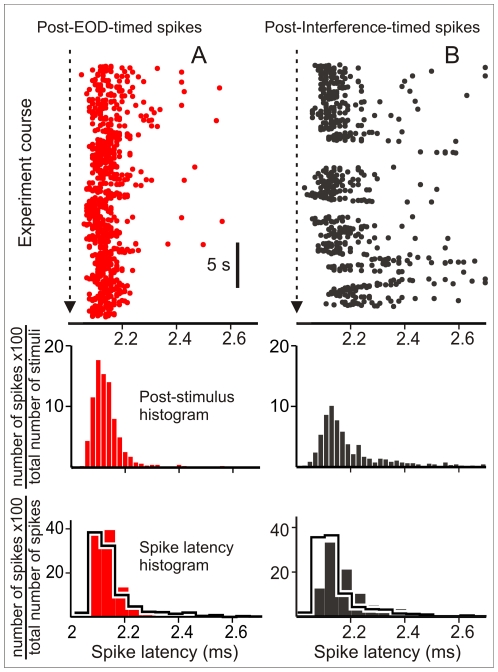
Interference and EOD timed stimuli are not equally effective.A) Top: Post stimulus raster plot of the spiking responses to EOD-timed pulses applied as in the natural sequence (red dots). Middle: corresponding post stimulus histogram (ordinate: 100× EOD evoked spikes per bin divided total number of EOD-timed stimuli, red bars). Bottom: The responsiveness to the natural patterns was compared with the responsiveness to the same set of intervals applied in a shuffled sequence in a pair wise experiment (histograms in heavy black lines). For the sake of clarity spike latency histograms showing the relative frequency of the latency after the cell spiked (ordinate: 100× EOD evoked spikes per bin divided total number of EOD evoked spikes) were constructed with a different bin size. B) Top: Post stimulus raster plot of the spiking responses to interfering pulses timed as in the natural sequence (black dots). Middle: corresponding post stimulus histogram (ordinate: 100× interference evoked spikes per bin divided total number of interference-timed stimuli, black bars) Bottom: The responsiveness to the natural patterns was compared with the responsiveness to the same set of intervals applied in a shuffled sequence in a pairwise experiment (histograms in heavy black lines). For the sake of clarity spike latency histograms showing the relative frequency of the latency after the cell spiked (ordinate: 100× interference evoked spikes per bin divided total number of interference evoked spikes) were constructed with a different bin size. In the natural sequence experiments the area (stimulus effectiveness) and the sharpness of the spike latency histograms (latency precision) in response to EOD-timed-stimuli (A, red post-stimulus histograms) were larger than those corresponding to interference (B, blue post-stimulus histograms). In the pair wise shuffled-EOD experiment the histograms are similar to each other (superimposed histograms in heavy black lines in the bottom panels of A and B).